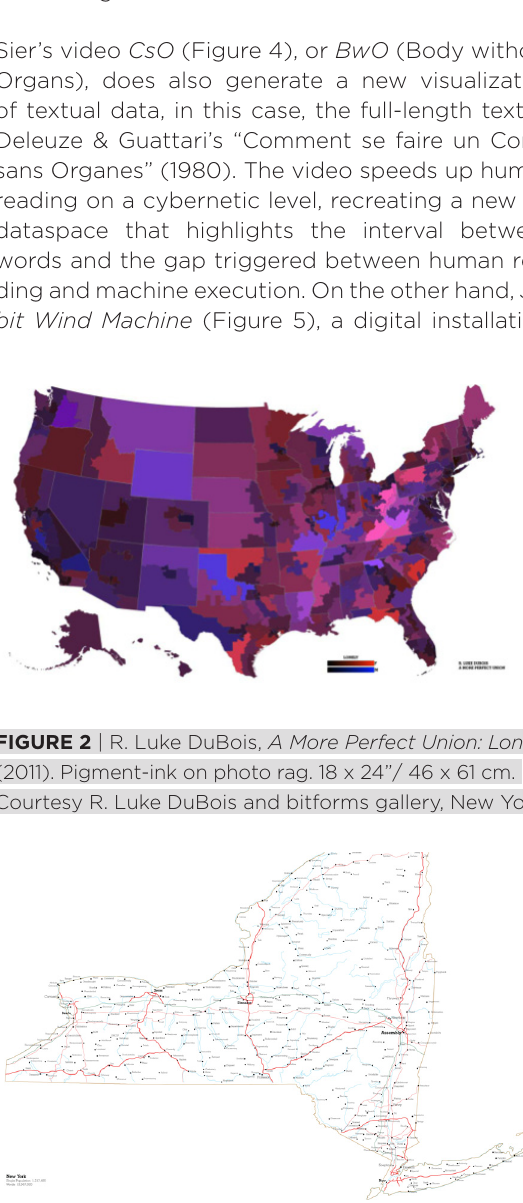
FIGURE 3 | R. Luke DuBois, A More Perfect Union, New York State (2011). Pigment-ink on photo rag. 24x36”/61 x 91.5 cm. Courtesy R. Luke DuBois and bitforms gallery, New York.